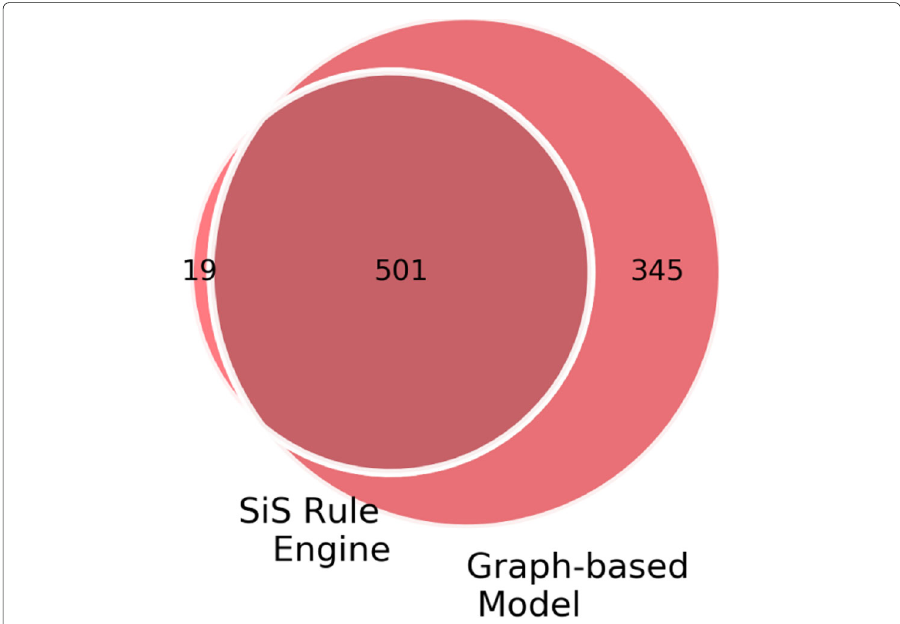
Fig. 12 Distribution of “low” legitimacy label. The low legitimacy label corresponds to an abnormal